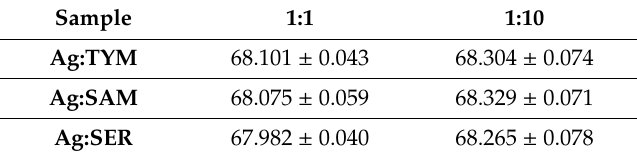
Table 3. Ag until cell volume (Å 3 ) for washed Ag:plant 1:1 and 1:10 samples.